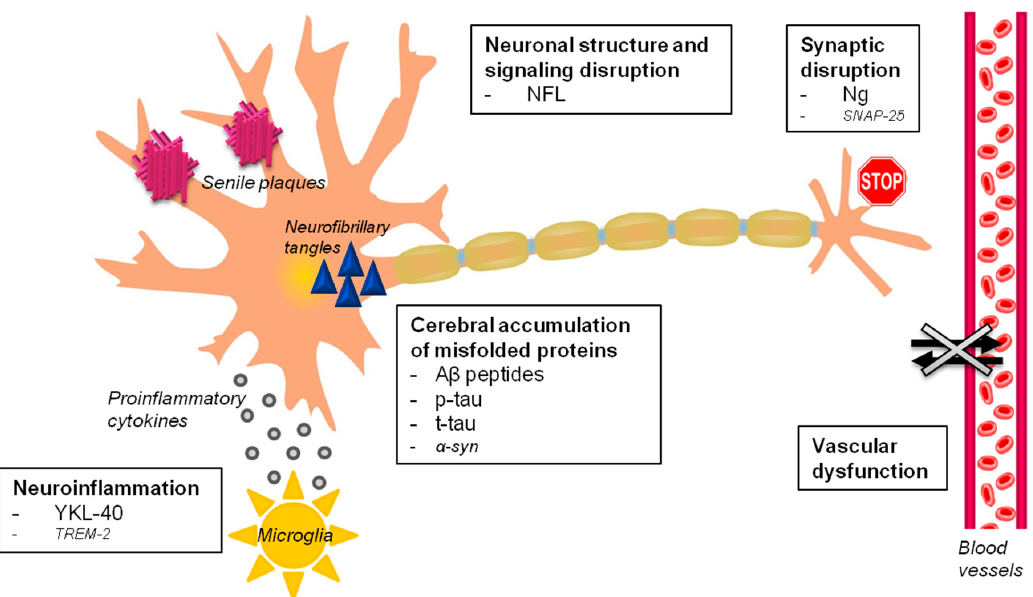
Figure 1. Alzheimer’s disease fluid biomarkers . The major pathophysiological processes involved in Alzheimer’s disease (in bold) with validated and proposed fluid biomarkers are schematically represented. Fluid biomarkers of vascular dysfunction, and of TAR DNA binding protein 43 (TDP-43) and α -syn pathologies are still missing. Abbreviations: A β , β -amyloid, α -syn , α -synuclein; NFL , neurofilament light chain; Ng , neurogranin; p-tau , phosphorylated tau protein; t-tau , total tau protein, synaptosomal-associated protein 25 (SNAP-25), and triggering receptor expressed on myeloid cells 2 (TREM2).